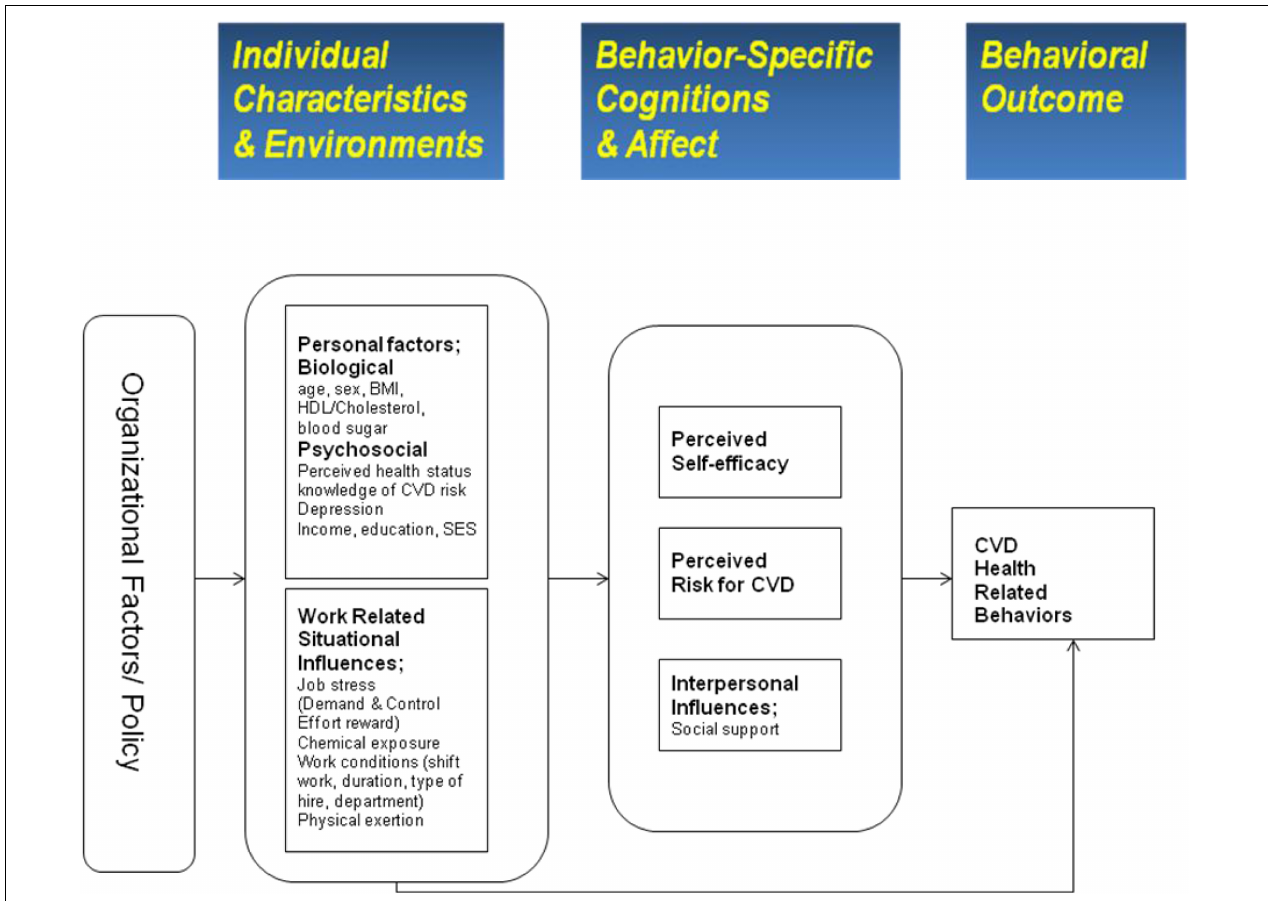
FIGURE 3 | Conceptual framework for CVD health related behavior in blue collar workers. Potential determinants of CVD risk perception and risk-reduction behaviors. Adapted from the Health Promotion